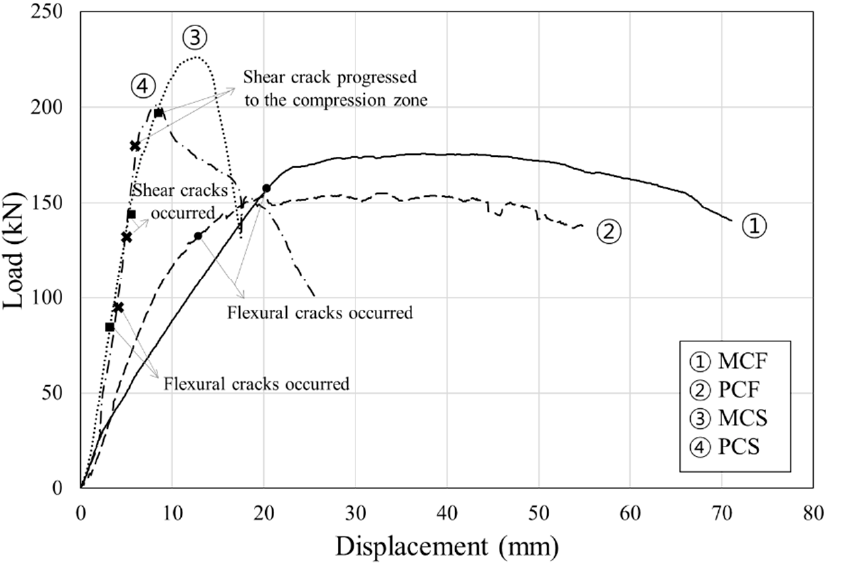
Figure 11. Load–displacement